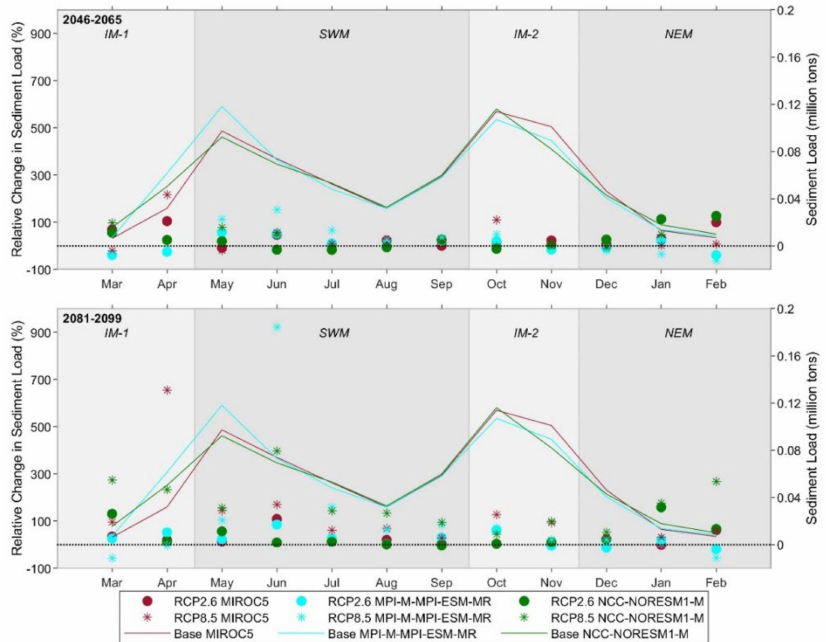
Figure 8. Percentage change in projected mean monthly sediment loads at the basin outlet relative to the baseline period (1991–2005) and absolute sediment loads for simulations of individual RegCM4 RCM. In each panel, relative changes for future periods are in the primary (left Y-axis) and sedi- ment loads for baseline periods are in the secondary axis (right Y-axis). The top panel shows the mid-century period (2046–2065), and the bottom panel shows the end-century period (2081–2099). Each panel shows the results of three RegCM4 RCMs (MIROC5, MPI-M-MPI-ESM-MR, and NCC- NORESM1-M) under RCP 2.6 and 8.5. The shaded areas represent the four monsoon